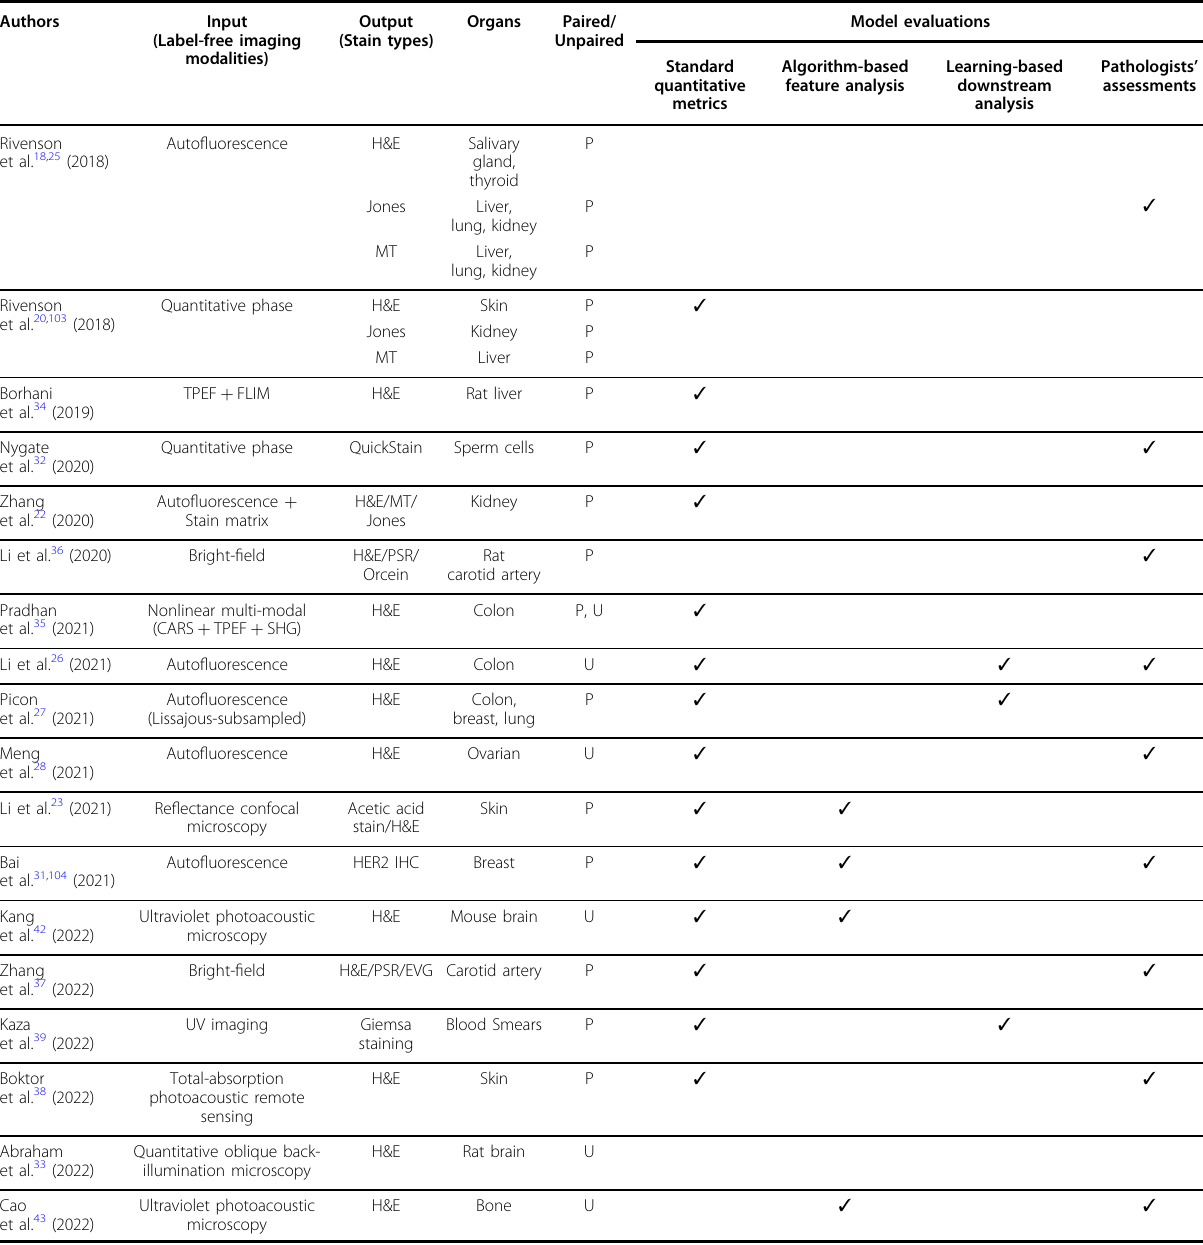
Table 1 Label-free virtual staining studies using deep